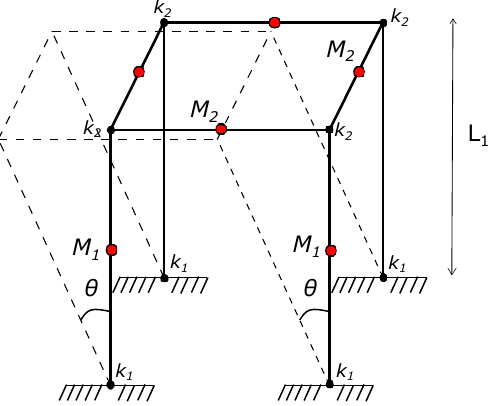
Figure 7. Model of the